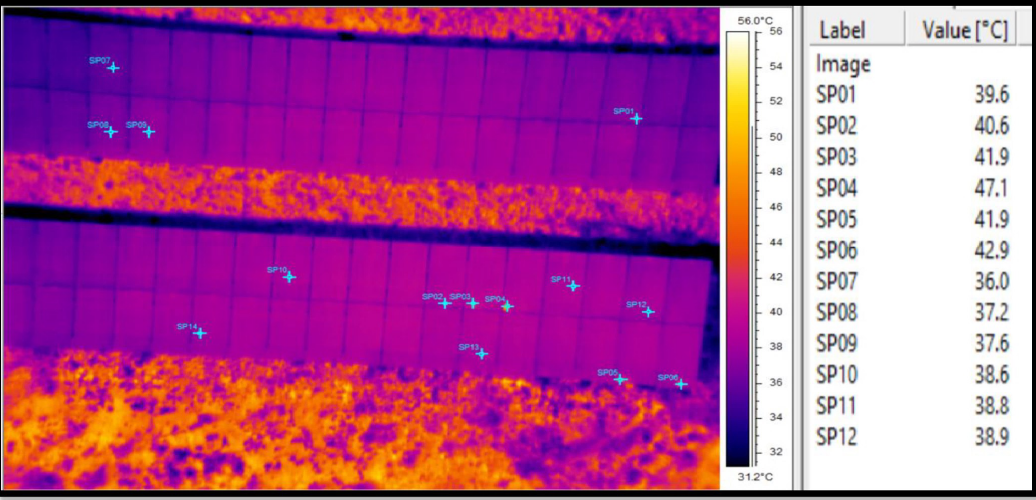
Figure 8. Temperature of hotspots of the thermal